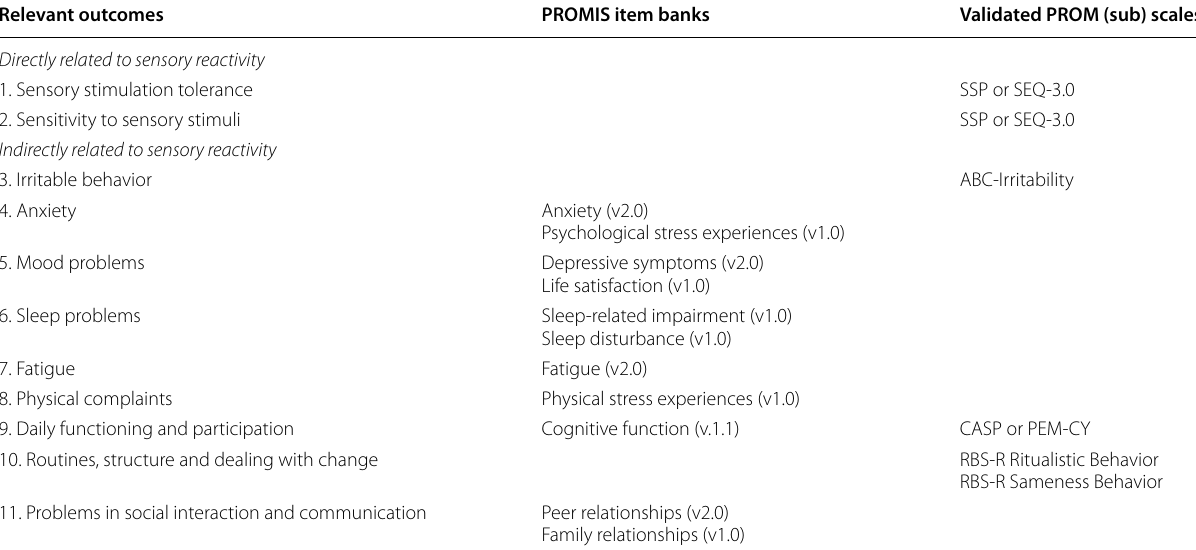
ABC, Aberrant Behavior Checklist; CASP, Child and Adolescent Scale of Participation; PEM-CY, Participation and Environment Measure for Children and Youth; RBS-R, Repetitive Behavior Scale-Revised; SSP, Short Sensory Profile